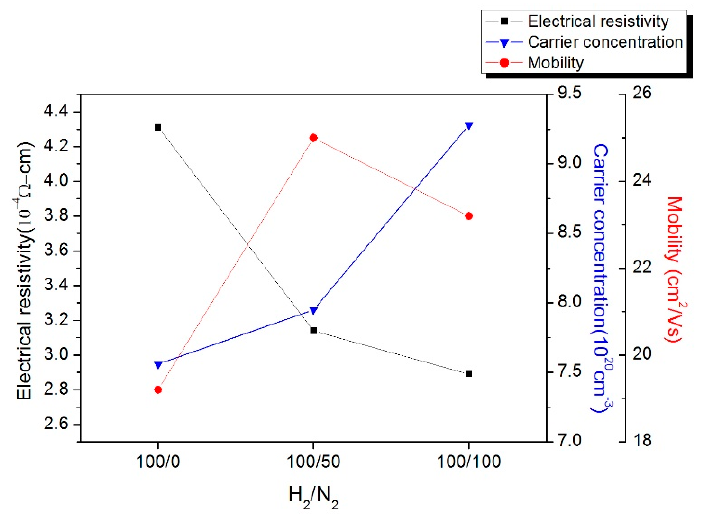
Figure 3. Electrical properties of the H 2 /N 2 plasma processed AZO/ITO films.